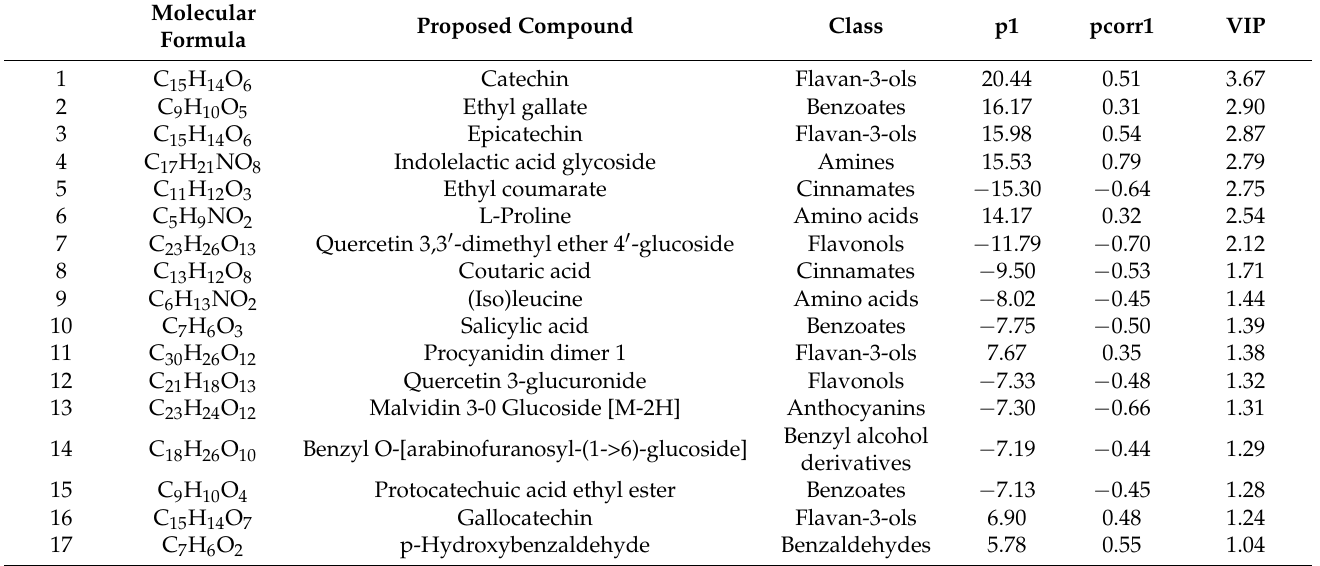
Table 2. List of discriminant VIP markers detected in red wines from different grape